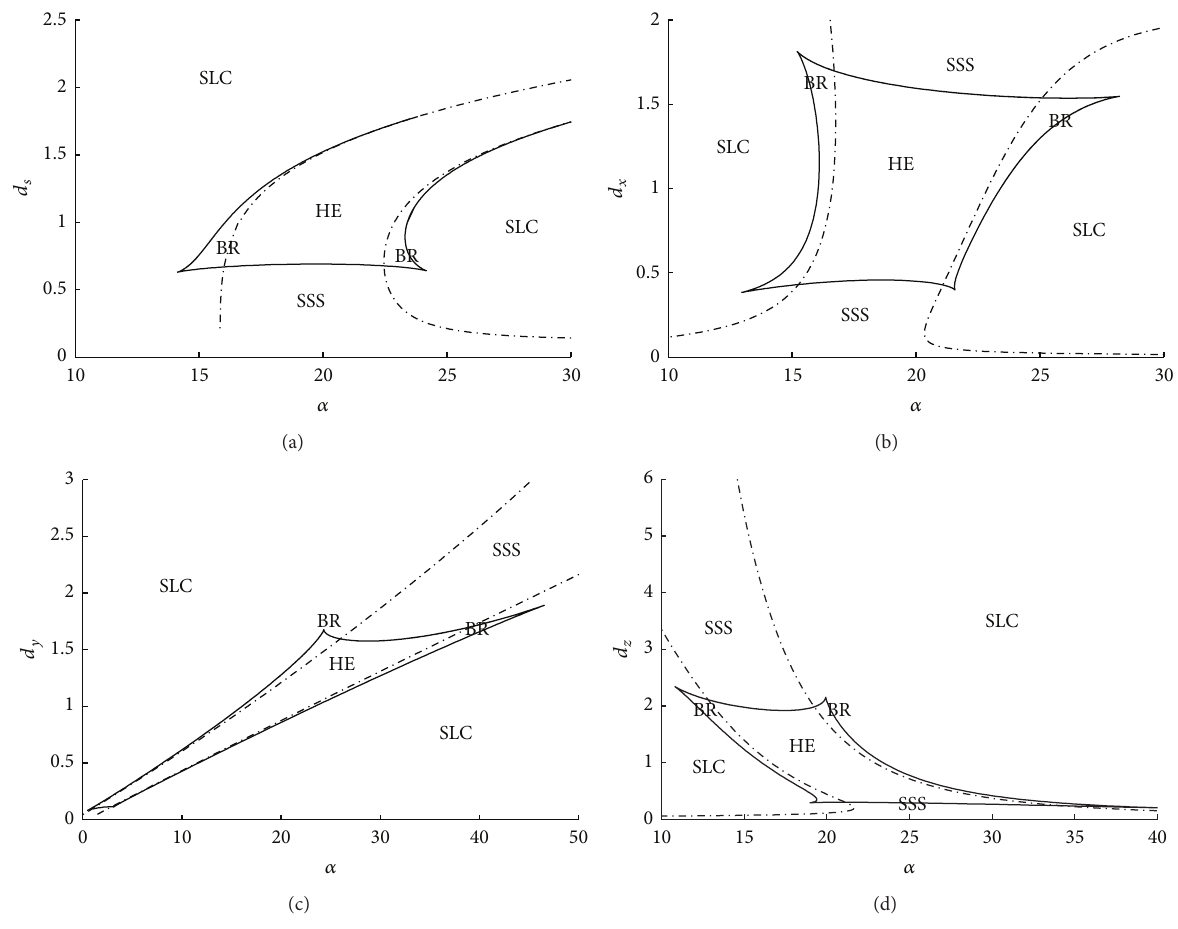
Figure 10: Bifurcation diagram of parameter 𝛼 versus parameters 𝑑 𝑠 , 𝑑 𝑥 , 𝑑 𝑦 , and 𝑑 𝑧 for model